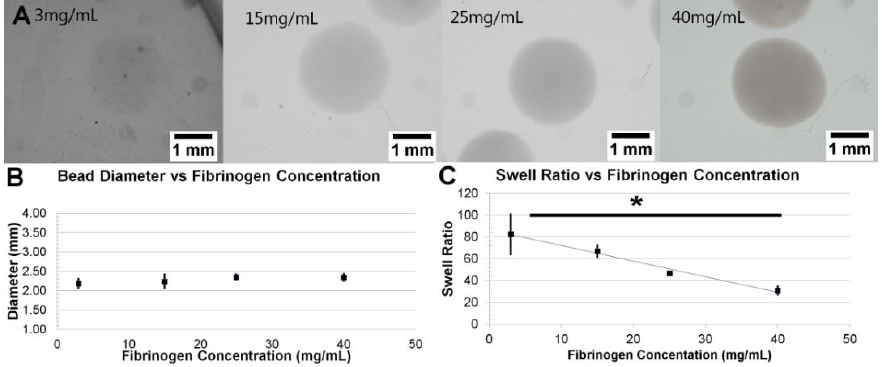
Figure 3. Variation of Bead Swelling Ratio with Fibrinogen Concentration: ( A ) Representative images of fibrin beads at various fibrinogen concentrations; ( B ) Graph showing no general relationship between bead diameter and fibrinogen concentrations ( p > 0.05); ( C ) Graph depicting the dependence of bead swell ratio on fibrinogen concentration ( p < 0.05).